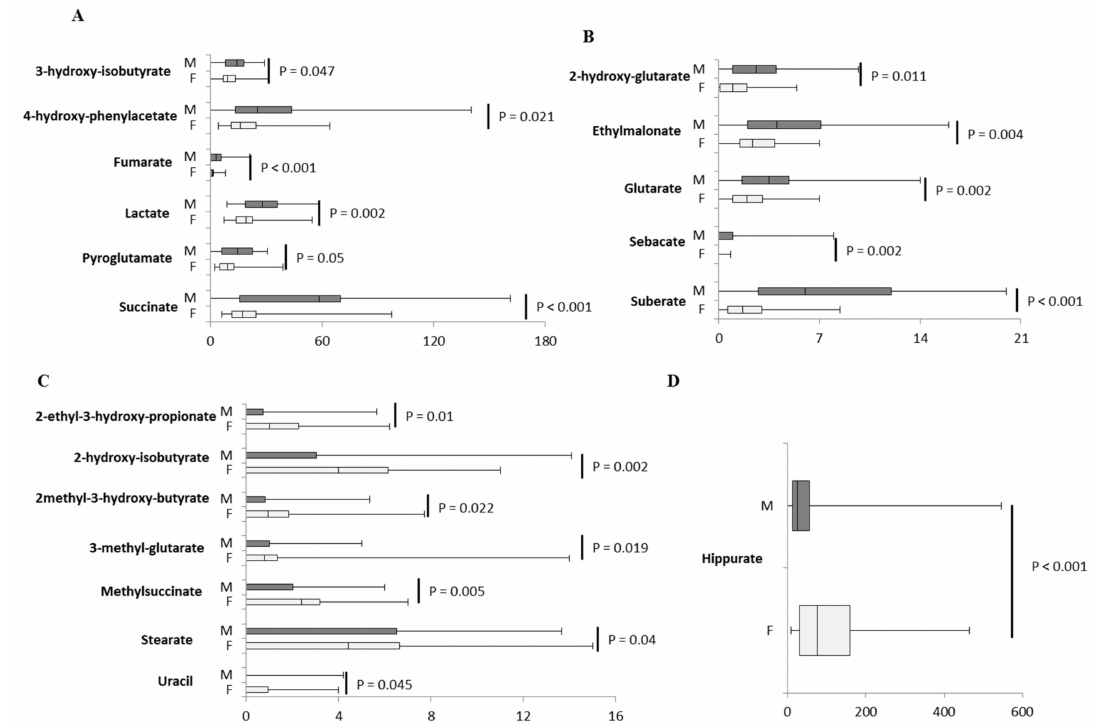
Figure 3. Box plot of urinary organic acids (mmol / mol creatinine) that sexually diverged in age group 1. Panels ( A – C ) reported metabolites divided according to the scale of values; ( D ) Sex di ff erenc in hippurate levels. The vertical line across the box represents the median, and the box comprises the first and the third quartiles. The horizontal lines represent the minimum and the maximum values. p -values for each urinary organic acid were reported. Sample size for each group is reported in Tables S2 and